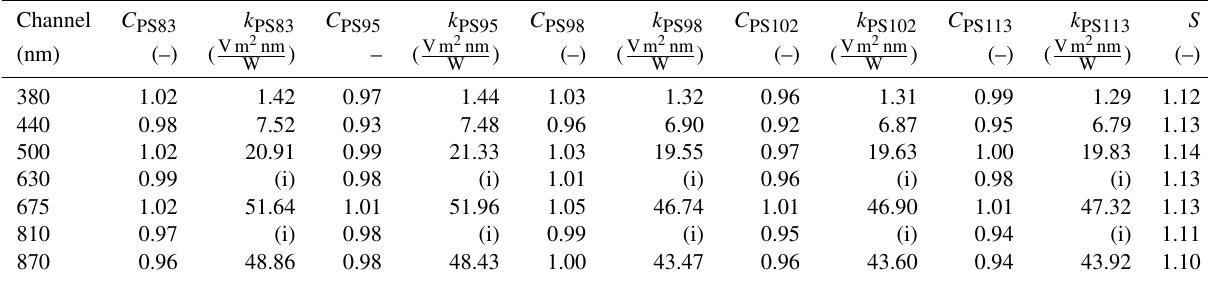
Table 3. Per-channel coefficients obtained for the cross calibration of the GUVis to the MIC instrumental channels (determined per cruise), expressed as relative correction C to the most recent laboratory calibration, together with the empirical scaling coefficient S to correct the AOD for the forward-scattering contribution in the GUVis observations (determined for all cruises). See text for details on their estimation. For comparison, the absolute calibration coefficient k for each cruise is shown. The channels of 630 and 810nm are non-native spectral channels and therefore marked with (i), as they are interpolated using the AE with Eq.